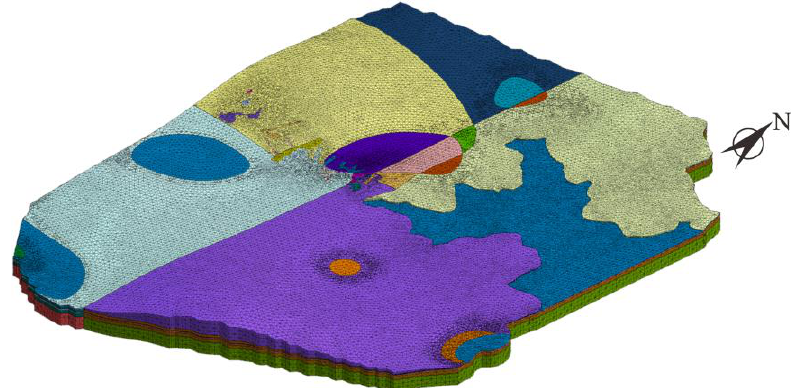
Figure 6. Three - dimensional hydrogeological model.